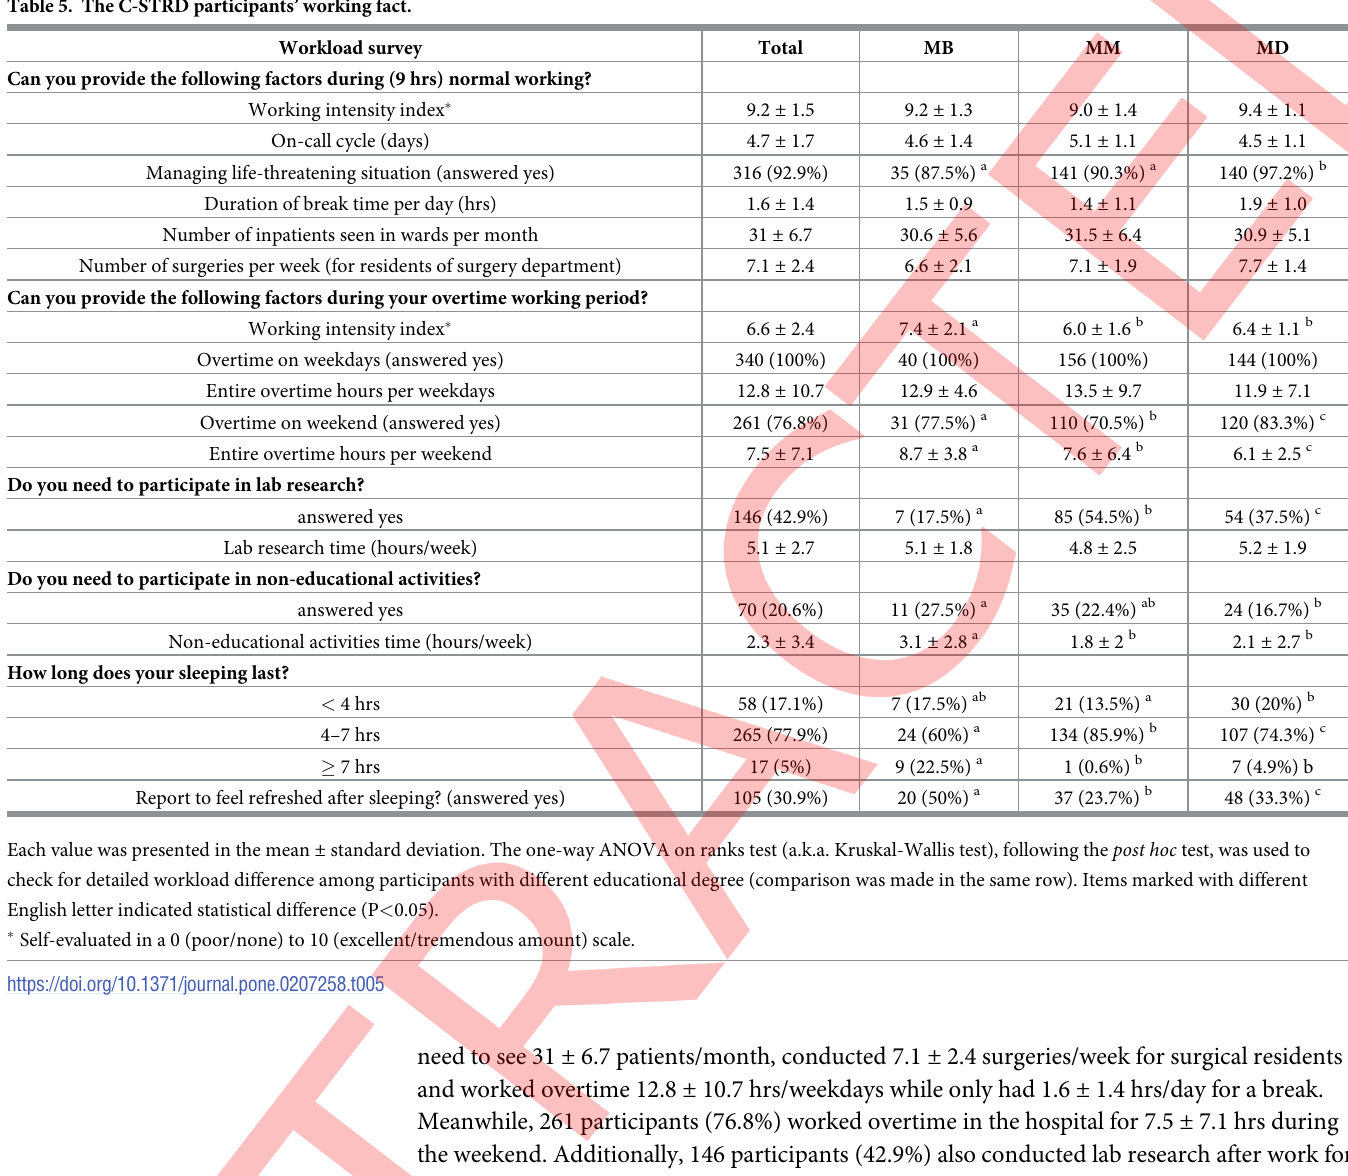
Table 5. The C-STRD participants’ working fact.